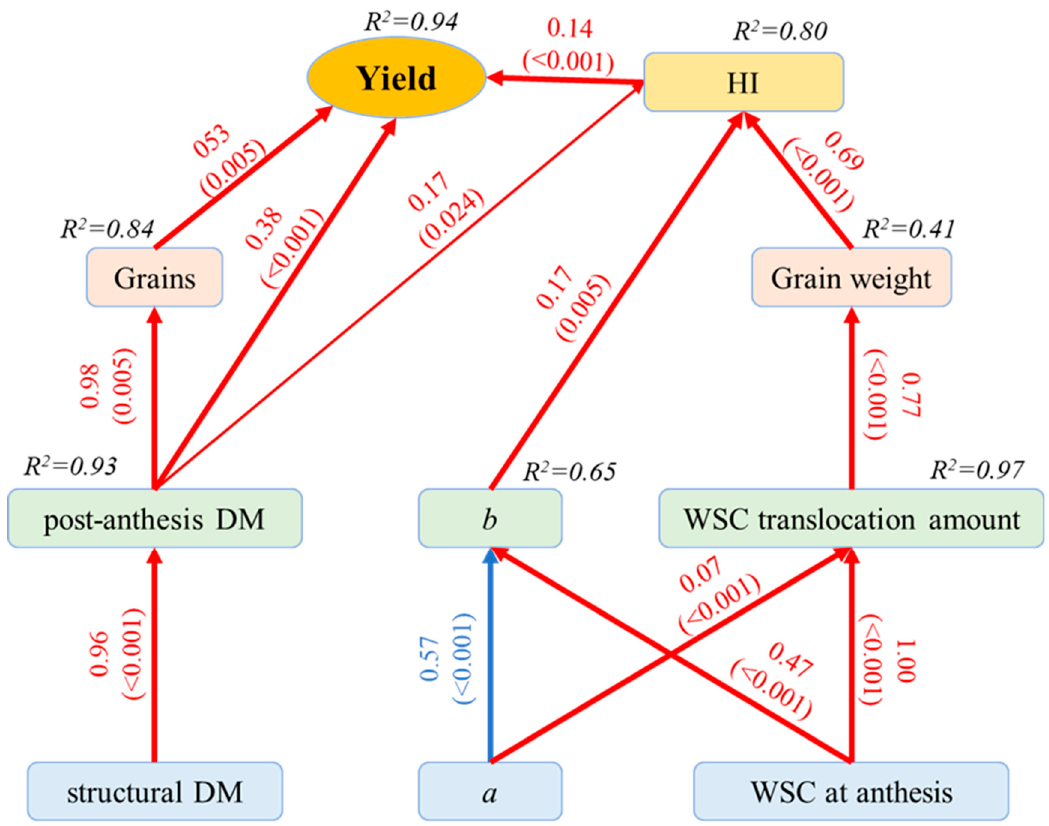
Figure 5. Structural equation modeling showing the relationship between yield and its components grain weight, grain number, harvest index (HI) and structural dry matter (DM) at anthesis, water- soluble carbohydrates content at anthesis (WSC at anthesis), coefficients of the exponential equation describing the dynamics of the flag leaf C:N ratio after anthesis ( a, b ), apparent translocation amount of WSC (WSC translocation amount), and post-anthesis dry matter (DM). Numbers next to arrows are the standardized coefficient and p in parentheses. The goodness of fit was 0.90. Blue arrows denote negative correlations and red arrows denote positive correlations. The thickness of the arrow indicates the significance of the relationship.